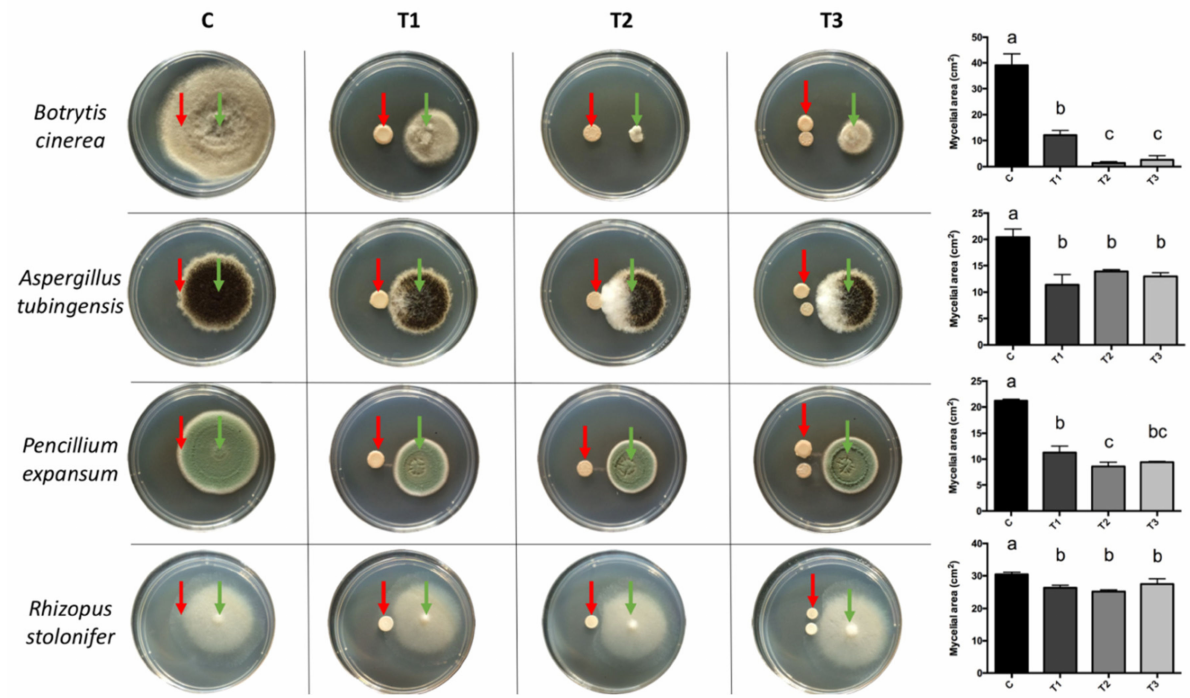
Figure 1. Dual cultures of BCAs (red arrows) with pathogens (green arrows). For all pathogens, an inoculum of 20 µ L was used at a concentration of 1 × 10 5 conidia mL − 1 . The concentration for G. cerinus was 1 × 10 6 CFU mL − 1 and 1 × 10 4 cells mL − 1 for H. osmophila . (C) Control: 20 µ L of sterile distilled water, (T1) 20 µ L of G. cerinus , (T2) 20 µ L of H. osmophila , and (T3) 10 µ L of G. cerinus and 10 µ L of H. osmophila . Vertical bars represent standard deviation and different letters indicate significant differences according to Tukey’s test ( p <